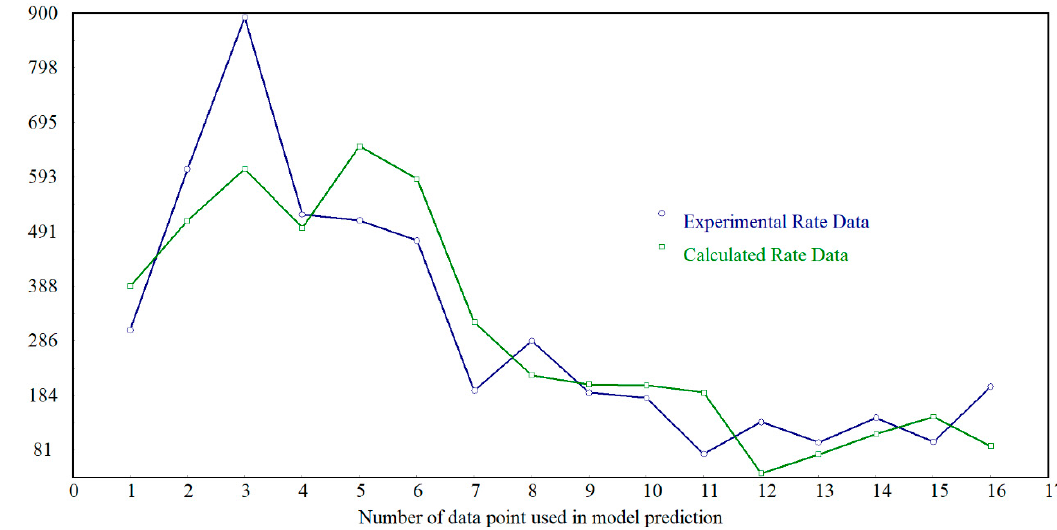
Figure 8. The goodness of fit data for the model Equation (1).